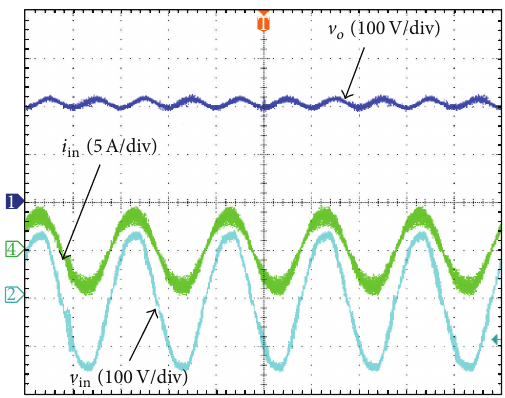
Figure 7: Block diagram of one-cycle control bridgeless Bipolar- Gain Pseudo-Boost PFC converter. Figure 8: Waveforms of DC output voltage V 𝑐 , AC input voltage V in , and AC input current 𝑖 𝐿